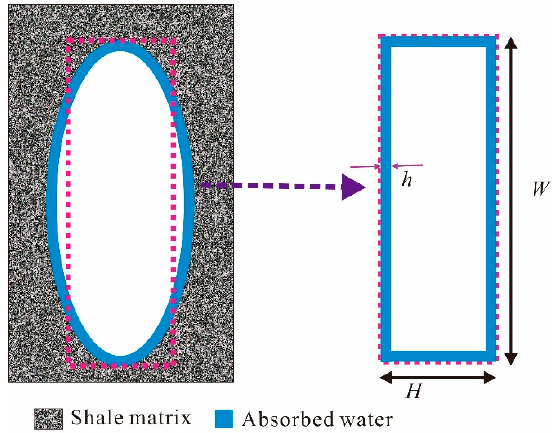
Figure 3. E ff ective hydraulic aperture for inorganic Figure 3. Effective hydraulic aperture for inorganic pores.